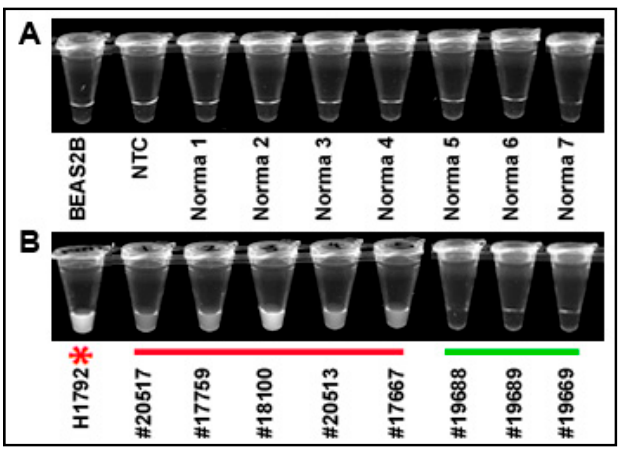
Figure 6. Directly visualizing the results of CRISPR–Cas12a for the detection of G12C mutation by naked eyes: ( A ) BEAS2B normal lung cells, NTC, and seven representative noncancerous lung tissue specimens had a negative result; ( B ) the five lung tumor specimens underlined in red and the H1792 cancer cells with a red star (#20517, 17759, 20513, 17567, and 18100) were positive for the 12G12 mutation as demonstrated by super-bright fluorescence signals. Three representative lung tumor tissue specimens underlined in green (#19688, 19689, and 19669) were negative for the mutation as demonstrated by the lack of fluorescence signal.